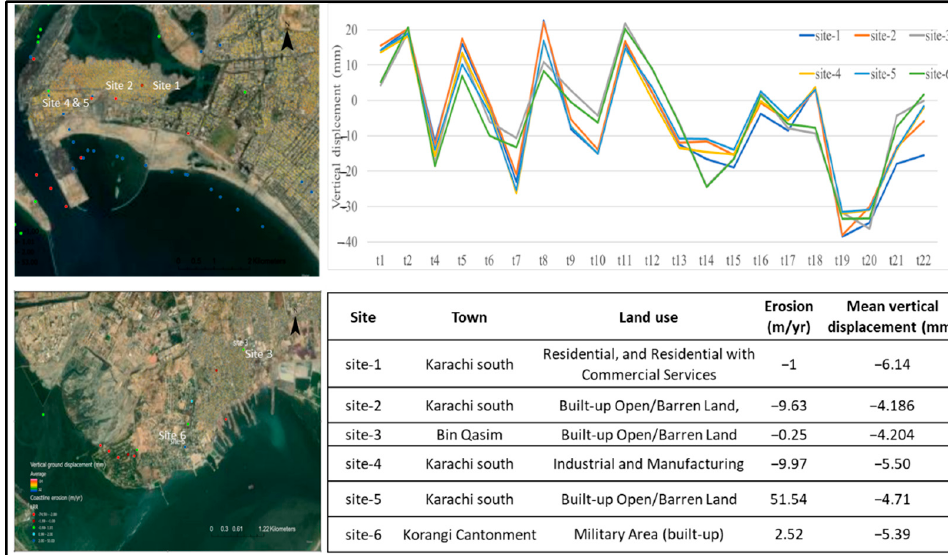
Figure 12. Location of six sites selected for coastline erosion and mean vertical displacement ( left ) spatial analysis. Mean vertical ground displacement time series from Envisat/ASAR 2014–2016 ( top right ) and land use, coastline change rate, and displacement values at each site in different coastal towns of the study area ( bottom right ).